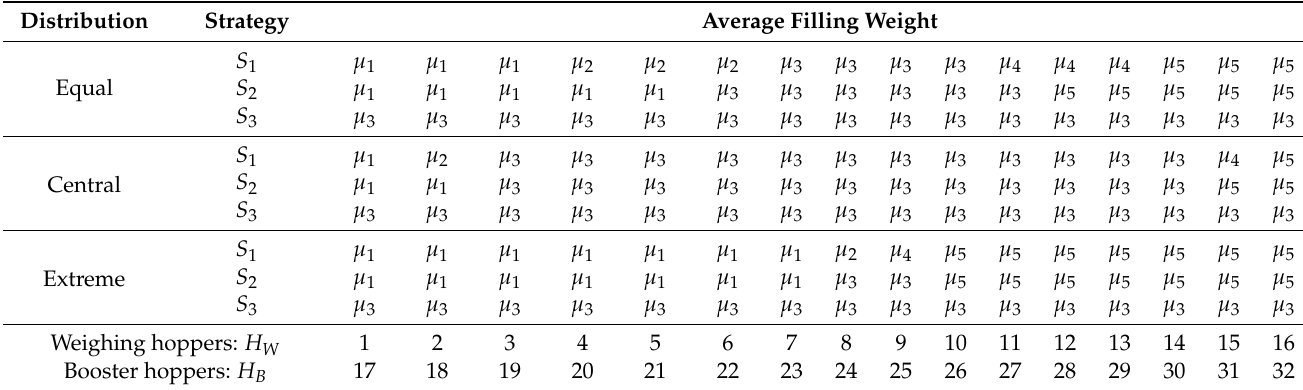
Table 4. Average filling weight according to the S 1 , S 2 , and S 3 strategies for equal, central, and extreme distributions with n =